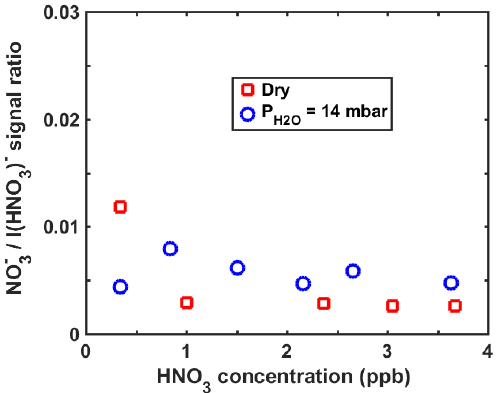
/ I(HNO 3 ) − as a function of HNO 3 Figure 3. Signal ratio of NO − 3 concentration under dry and humid conditions observed using io- dide as the reagent